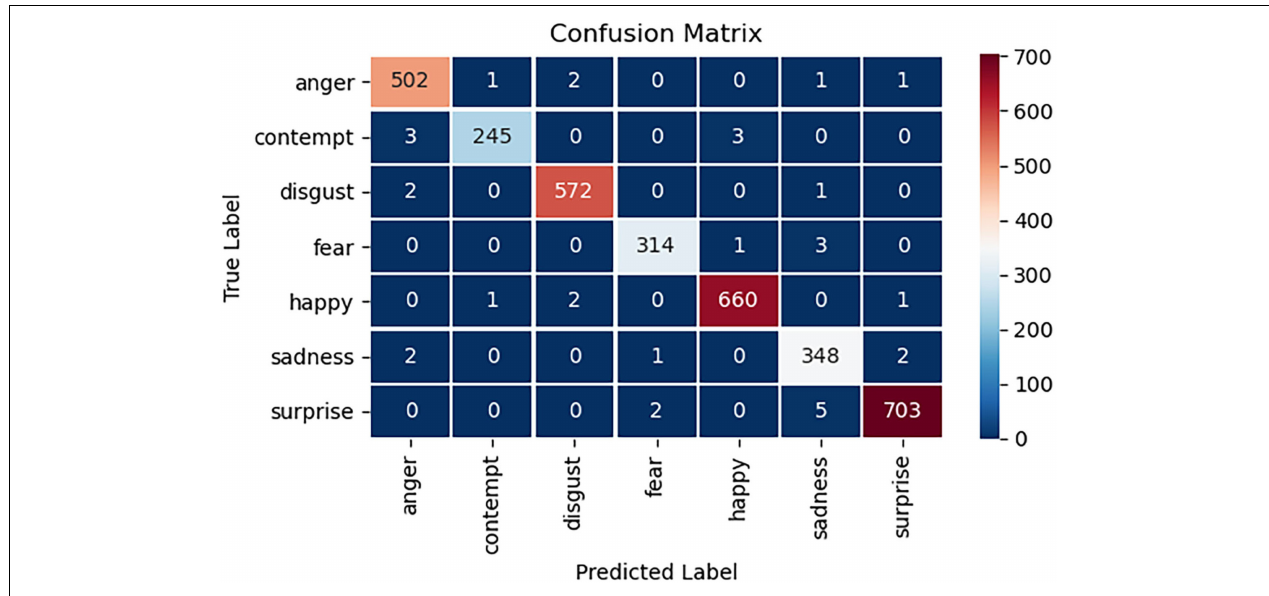
FIGURE 12 | Confusion matrix on the test set.